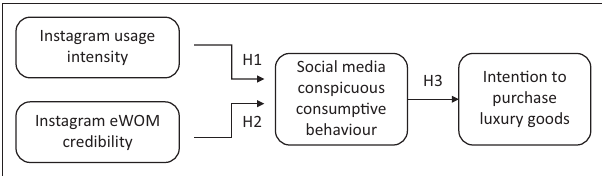
FIGURE 1: The conceptual